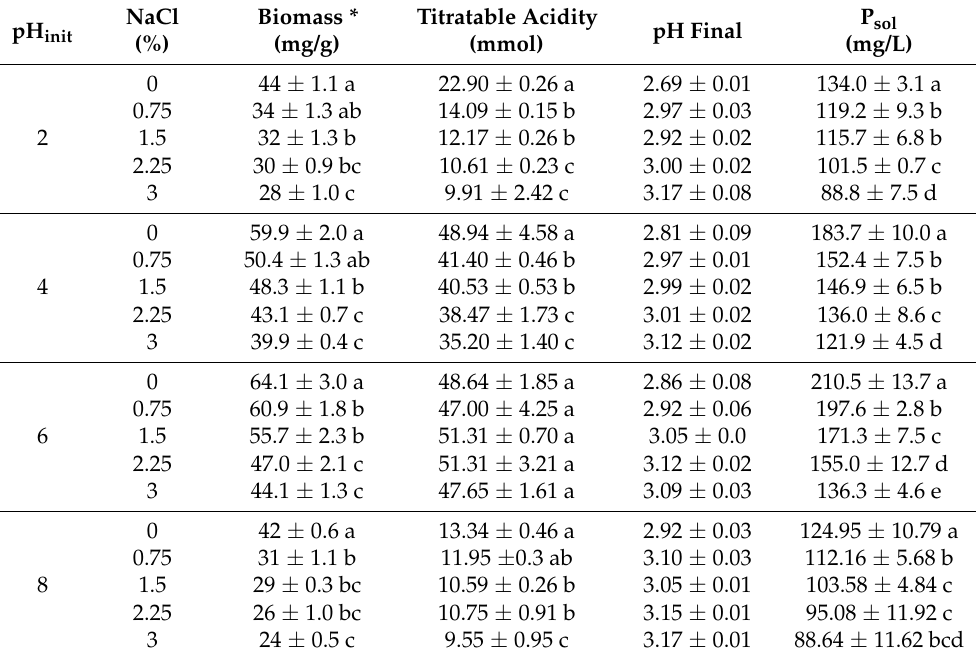
Table 2. Effect of pH and salinity on biomass growth, titratable acidity, and P-solubilization activity of P. bilaiae in conditions of solid-state fermentation. Mean ± standard error ( n = 3) is presented.